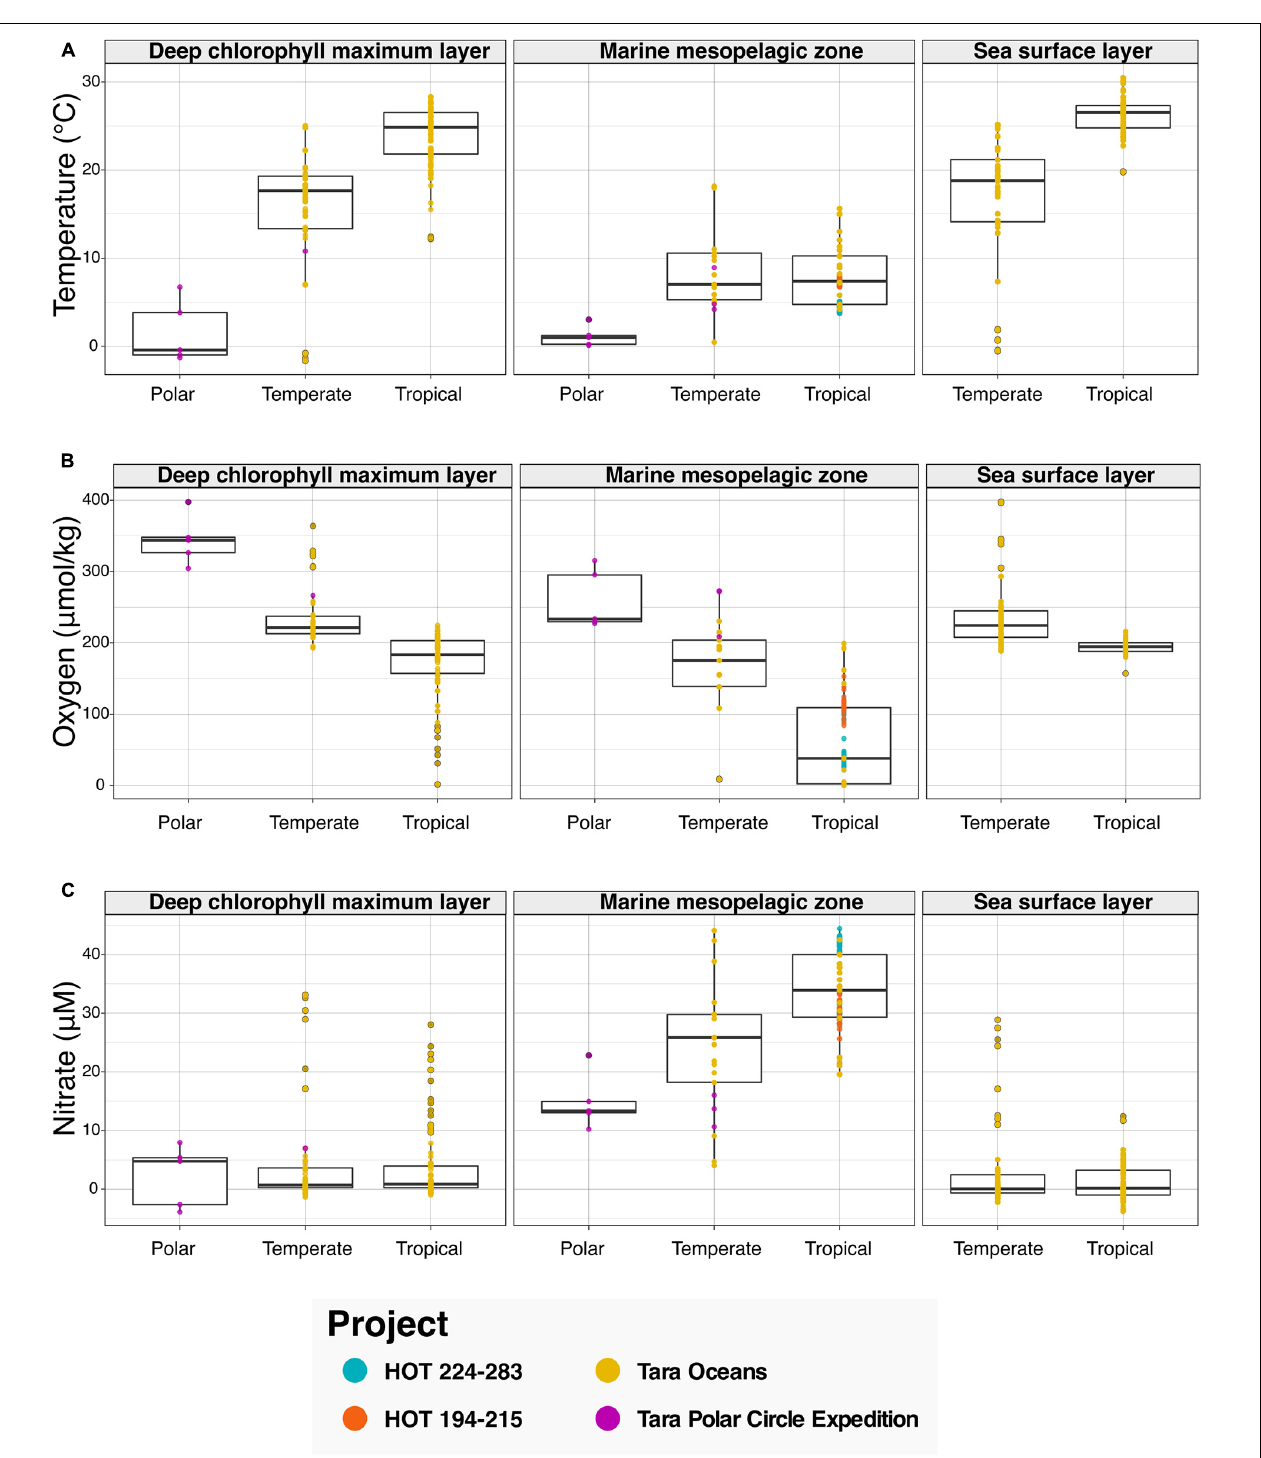
FIGURE 3 | Bar graphs showing physicochemical parameters faceted by annotation with various ENVO “ environmental feature ” (ENVO:00002297) terms serving as descriptors of environments. Data in this analysis are derived from various HOT and Tara projects that are annotated with the following ENVO terms: “ deep chlorophyll maximum layer ” (ENVO:01000326), “ marine mesopelagic zone ” (ENVO:00000213), and “ sea surface layer ” (ENVO:01001581). Additionally, the data are binned by latitude values into major climatic conditions “ polar ” (ENVO:01000238), “ temperate ” (ENVO:01000206), and “ tropical ” (ENVO:01000204). (A–C) The ENVO parameters: “ temperature of water ” (ENVO:09200014), “ concentration of dioxygen in liquid water ” (ENVO:3100011), and “ concentration of nitrate in liquid water ” (ENVO:3100022) in units of degree Celsius, and micromolar, respectively.